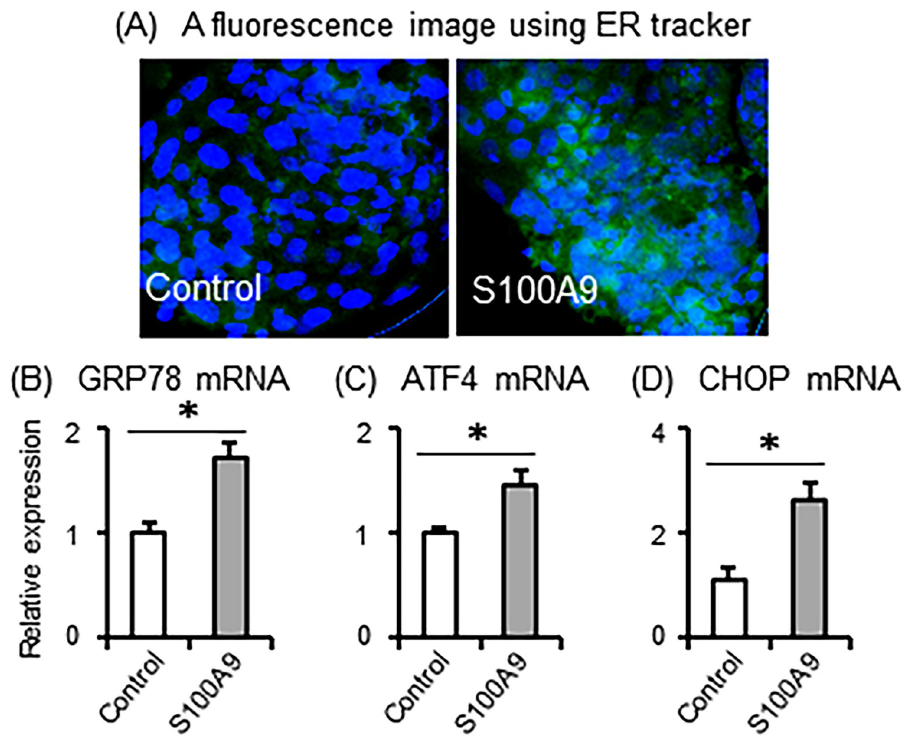
Fig 2. Effect of S100A9 exposure to blastocyst stage embryos on ER stress. Bovine blastocyst stage embryos were treated with 0 and 4 μ g/ml of S100A9 concentrations for 5 h. (A) A fluorescence microscopic image of embryos by ER tracker. (B-D) The mRNA expression of GRP78, ATF4, and CHOP was determined (relative to ACTB mRNA levels). All values are shown as mean ± SEM. ‘ � ’ indicates significant differences ( P <